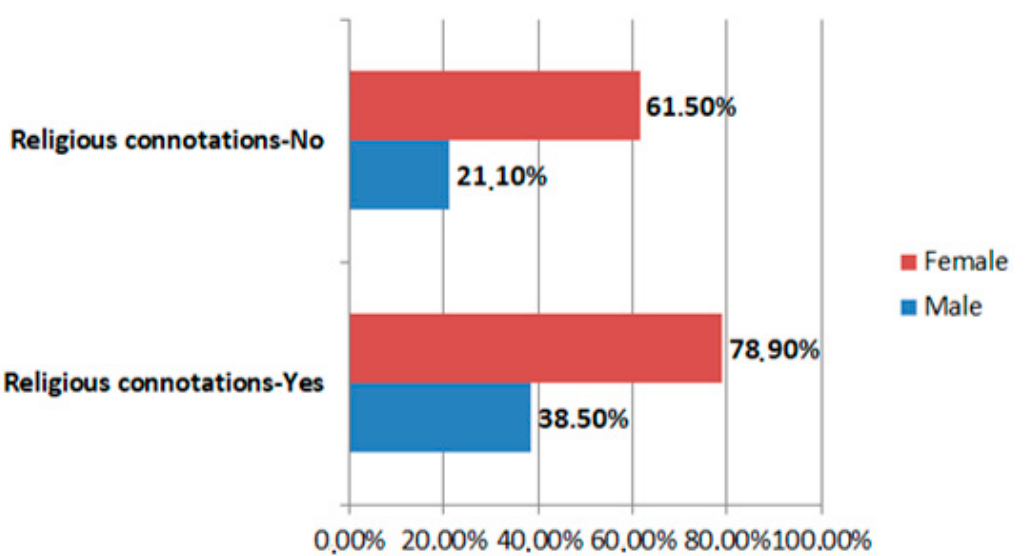
Figure 7. Religious connotations in terms of gender for the name Rebecca in the metropolitan district of Leeds.